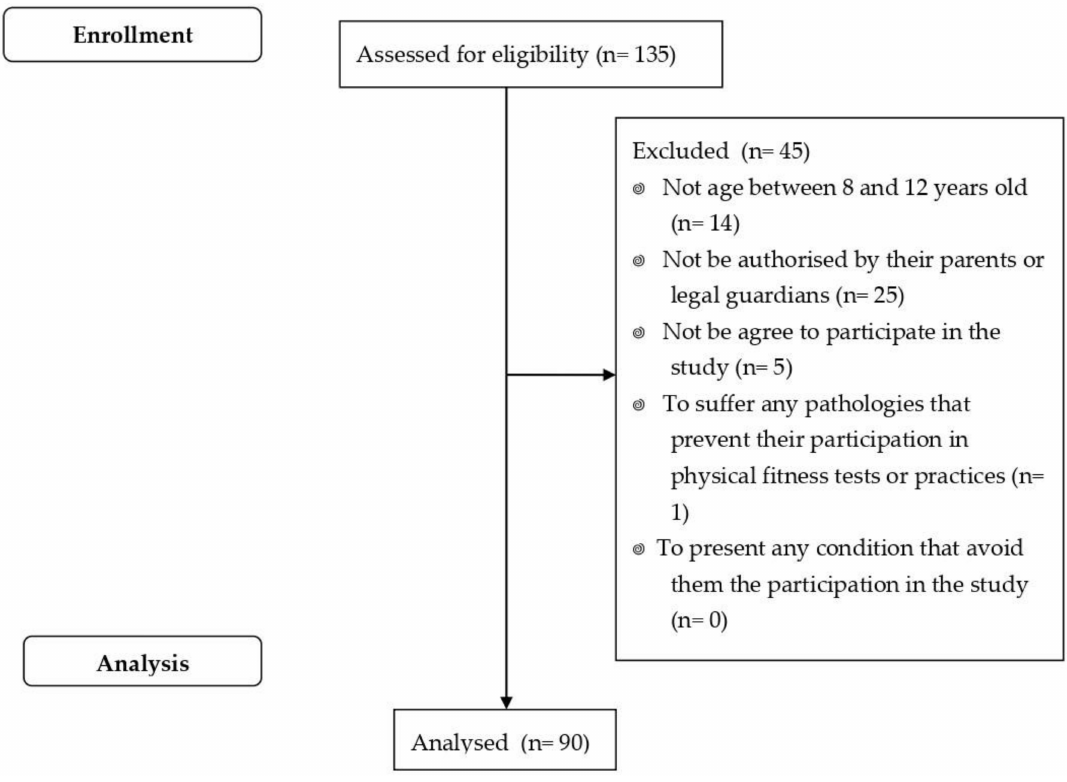
Figure 1. Participants selection flow